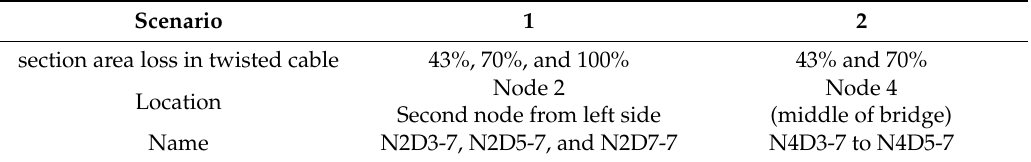
Table 3. Five damage scenarios considered in a laboratory model of the bridge.